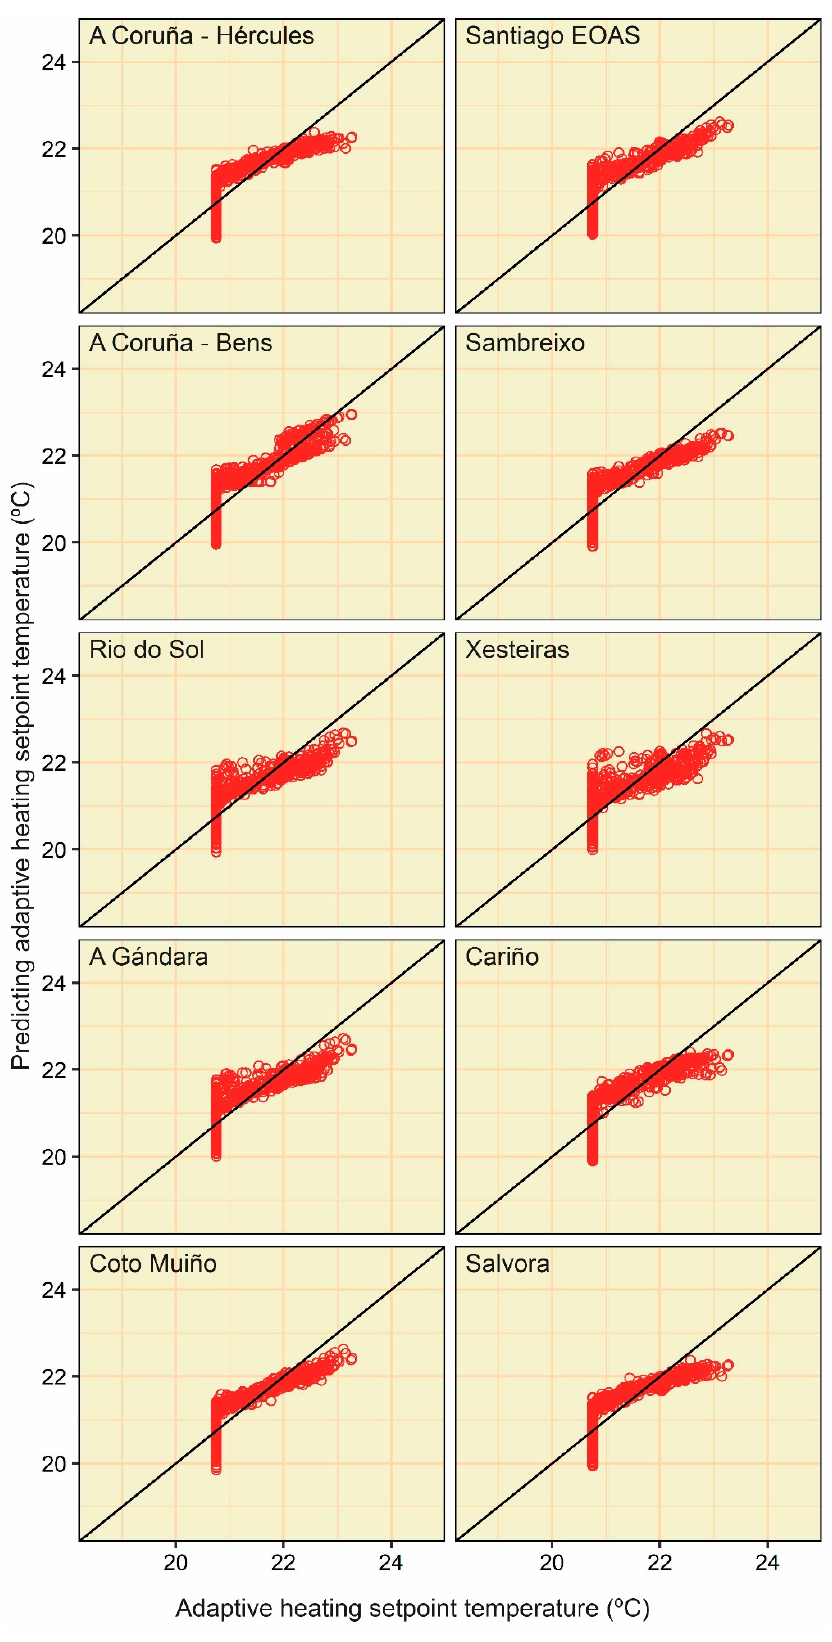
Figure A20. Point clouds between the actual and predicting adaptive heating setpoint temperature values (category II) of the MLR (approach 2).